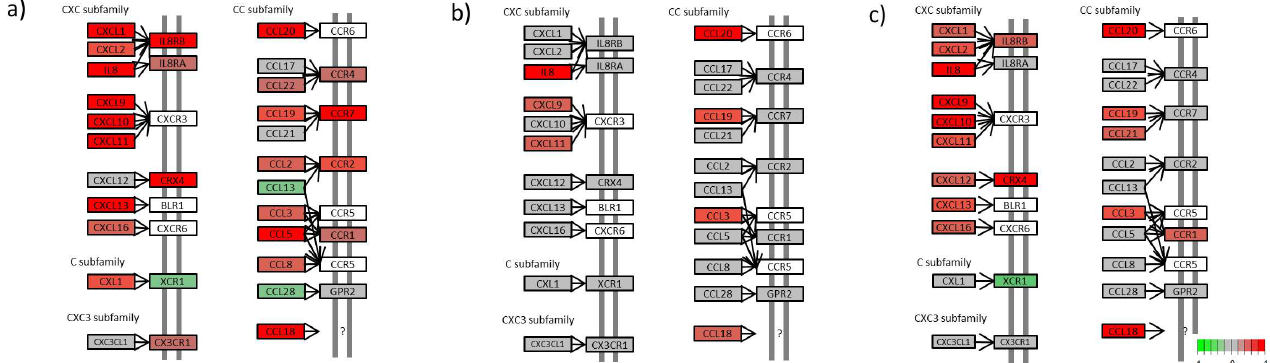
Fig 4. Cytokine-cytokine receptor interaction for the chemokines. (a) Untreatedlesionalversus nonlesional, (b) Untreatedlesionalversus 4 days after adalimumab treatment was initiatedand (c) Untreatedlesionalversus 14 days after adalimumab treatment was initiated. (Colours refer to the expressionlevel; green is downregulated, red is upregulatedin untreated lesionalpsoriaticskin, grey is not regulatedand white is not included in our data set) (Please find list of gene names in S4 Table).